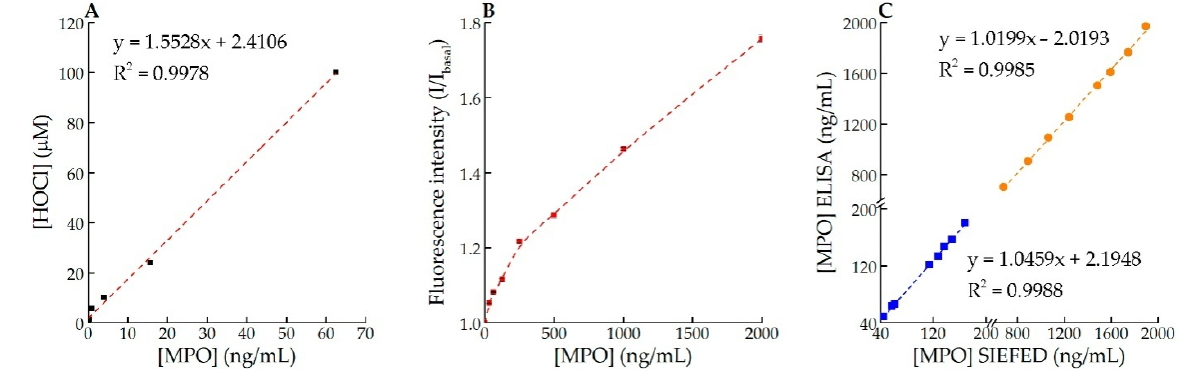
Figure 2. Assessing the MPO chlorinating activity in solution and in the SIEFED assay: ( A ) Production of HOCl ( μ M) during 20 min incubation of MPO (0–62.5 ng/mL) with the developer containing 200 μ M CB, 50 μ M H 2 O 2 , 2 mM Tau, 5 μ M KI, 250 mM NaCl, 100 mM Na–acetate buffer, pH 5.5; ( B ) I/I basal ( λ ex = 487 nm, λ em = 578 nm) obtained for MPO calibrators (31.3–2000 ng/mL) in the SIEFED assay; ( C ) Results of MPO assay (by SIEFED—abscissa and by ELISA—ordinate) in plasma samples taken every 30 min from heparin-stabilized blood incubated at 37 ◦ C during 4 h with 50 nM PMA (orange points) and without activator (blue